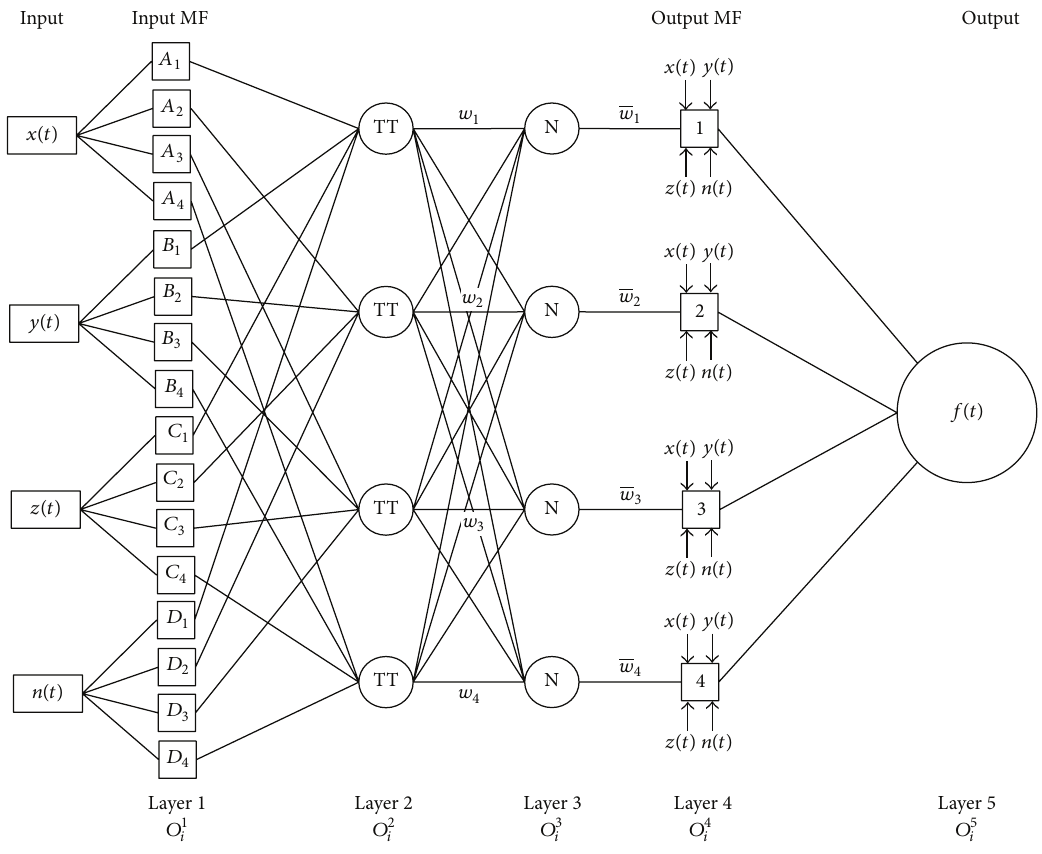
Figure 3: Typical neurofuzzy